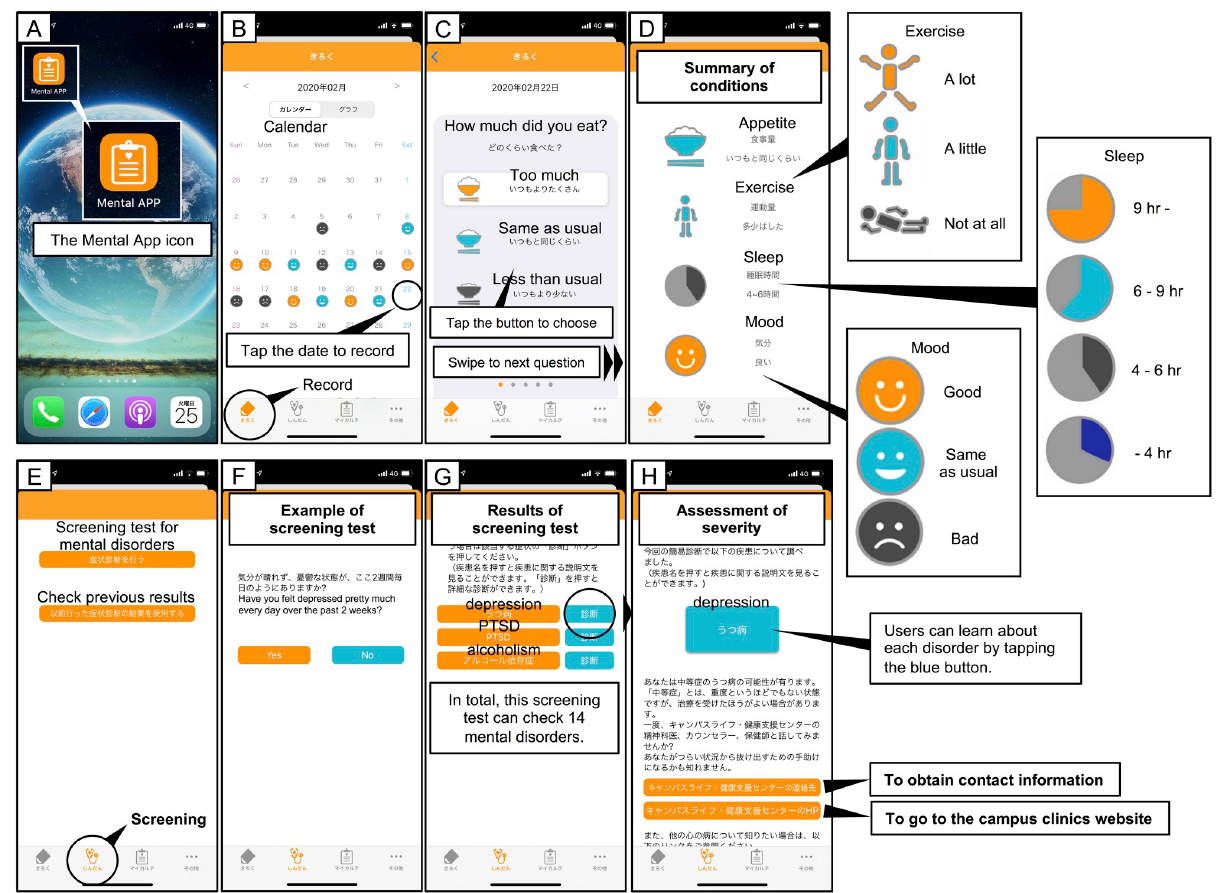
Fig 2. Screenshots of Mental App. Since the app is only available in Japanese, English captions are shown in the screenshots. (A) The Mental App icon. A magnified view is also shown. (B) The main screen of the record function. A calendar system was used to record daily conditions. Users can tap the date to record the conditions of that day. (C) Recording daily conditions. The screenshot shows a screen asking about users’ appetite for the day. Users choose the extent of their appetite by tapping the corresponding button. Users can swipe the screen to go to the next question. (D) The summary of the conditions of the day. In the record function, users can record their daily appetite, exercise, sleep time, and mood. (E) The main screen of the screening function for mental disorders. Users can start the screening test for mental disorders. (F) Example of the screening test. The screenshot shows the screening test for depression. (G) Results of the screening test. If the screening test was positive, more detailed tests for each disorder were offered to determine the severity. (H) Assessment of the severity of each mental disorder. According to the severity, the app offered the users advice and information (e.g., the contact information of the campus clinic or the nearest clinics, the website of campus clinic, a self-care website, and contact information of public consulting services). Furthermore, users could learn about each disorder by tapping the blue button.